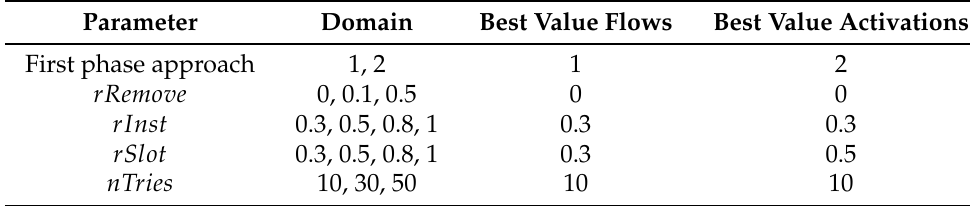
Table 3. Configuration of input